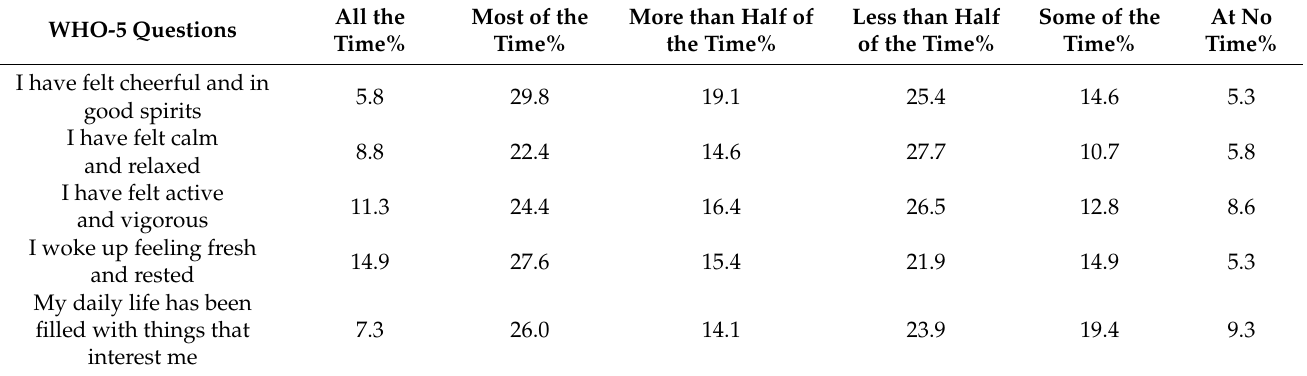
Table 1. Frequencies of the response about the well-being of the participants.